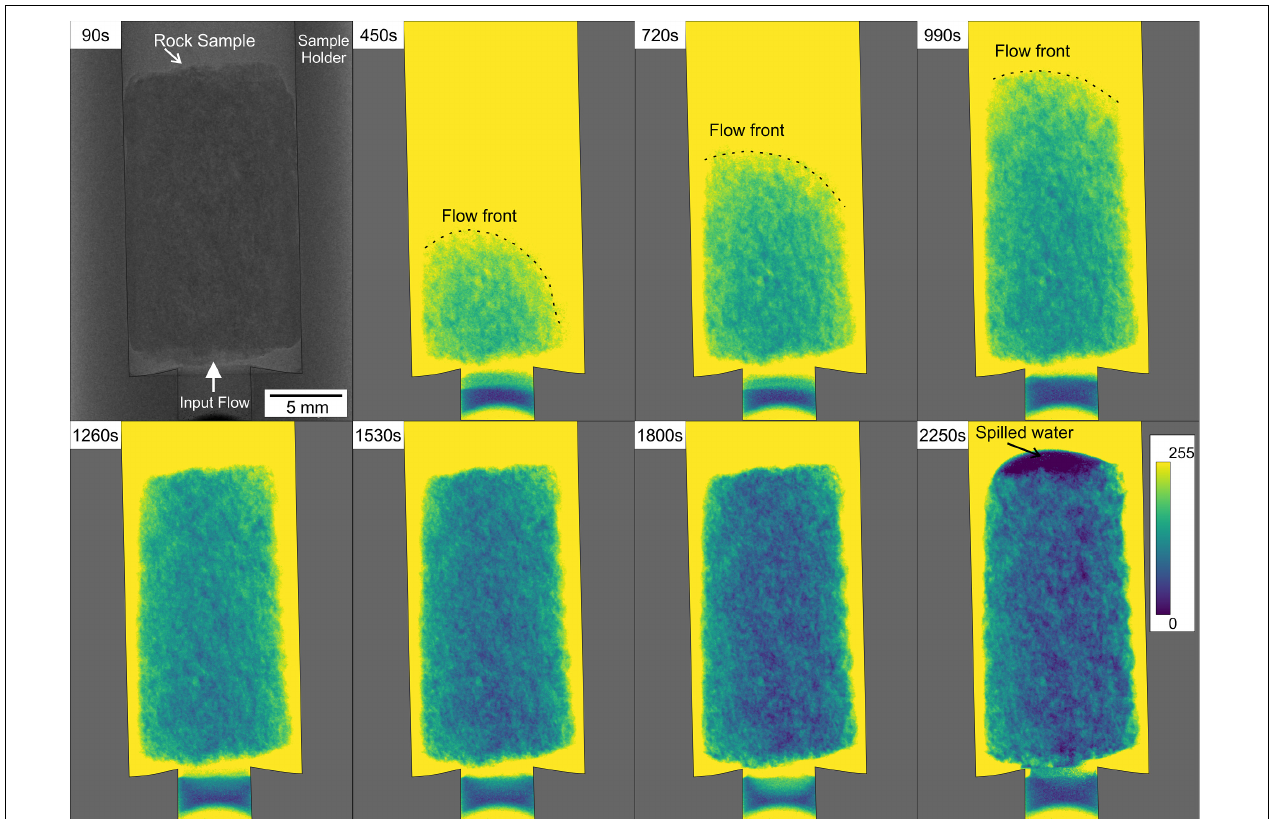
FIGURE 3 | Time lapsed neutron radiographs showing the flow of deionized water for the sample corresponding to a Favignana grainstone. The image at 90 s (in original gray scale color) corresponds to a stage where the water still not entered into the rock sample. The rest of the images (in false color) correspond to input fluid into the sample obtained by subtracting the original dry condition (90 s) to radiograph to the n-time radiograph. The stages from 450 to 990 s show the fluid filling the rock sample. The stages from 1260 to 2250 s show an increment in the fluid saturation until the water is spilled due to oversaturation.